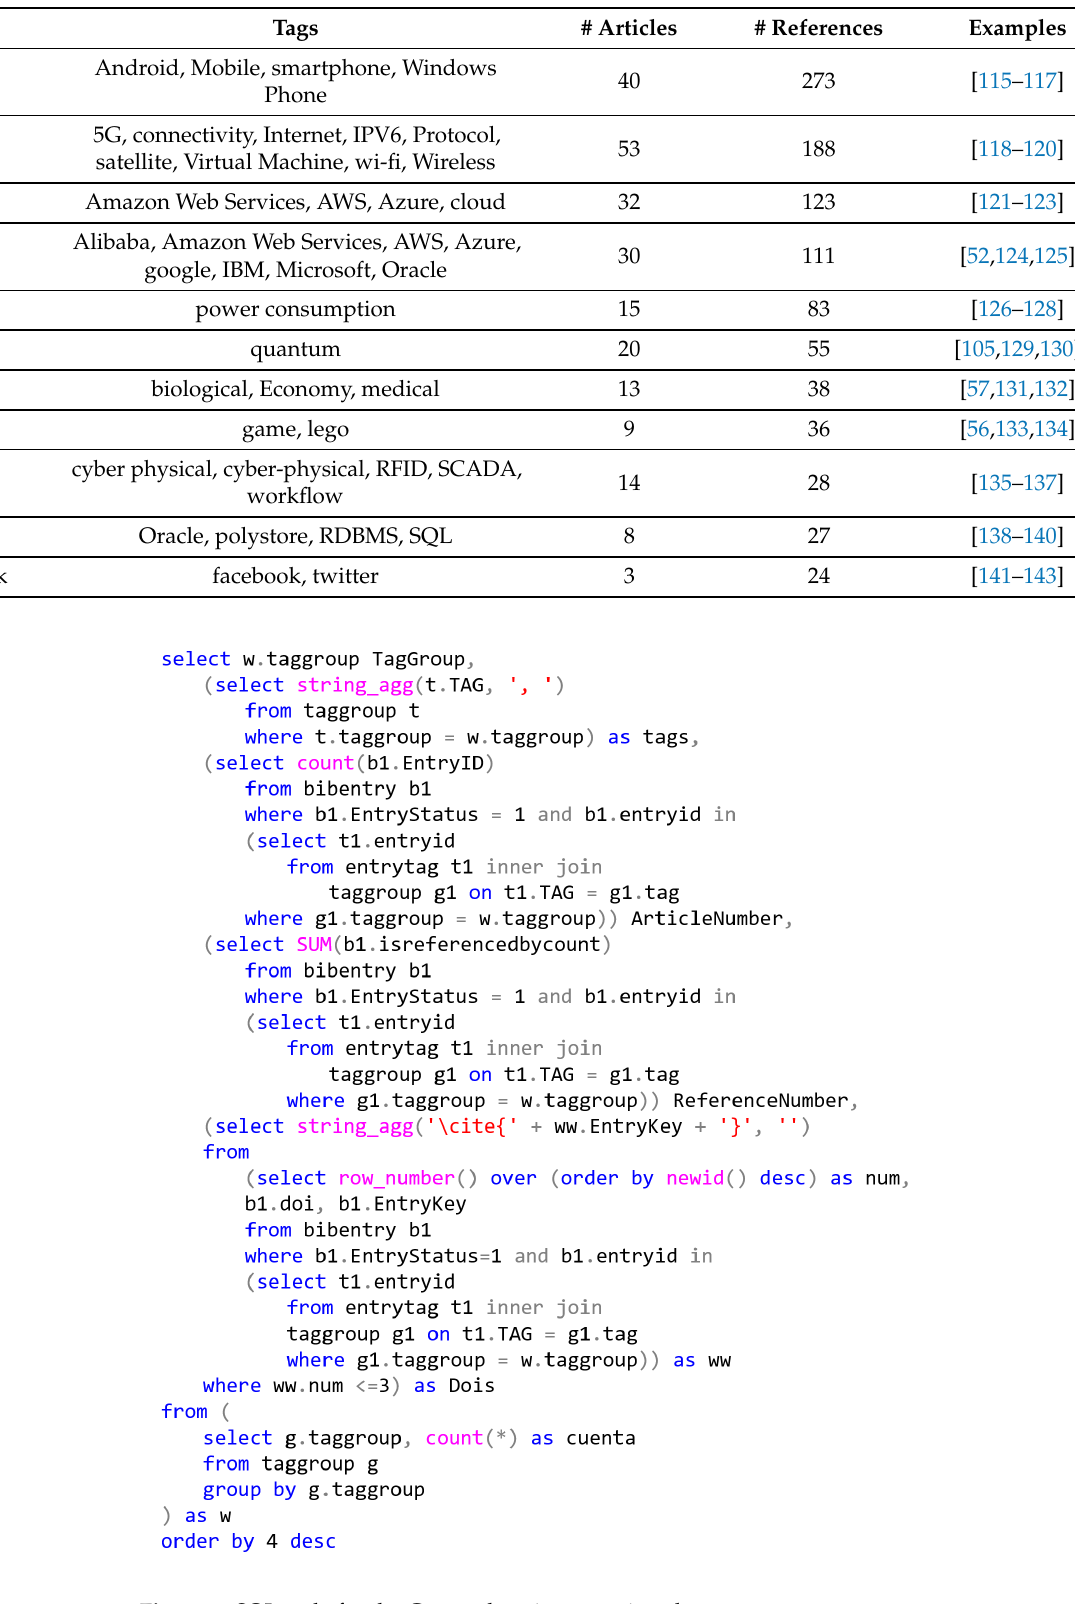
Figure 9. SQL code for the Comprehensive mapping